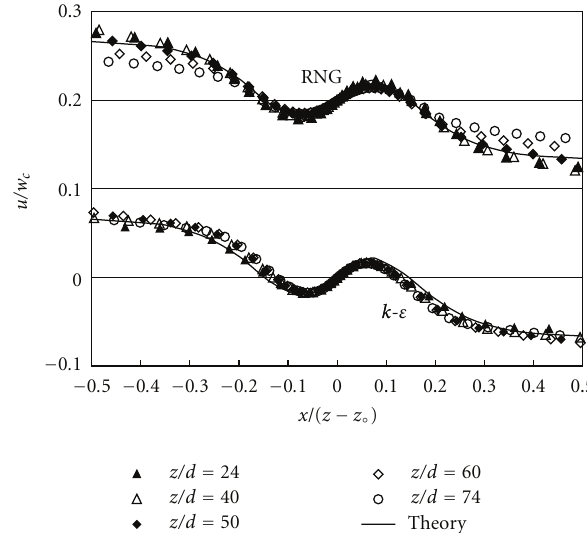
Figure 9: Profiles of lateral velocity in